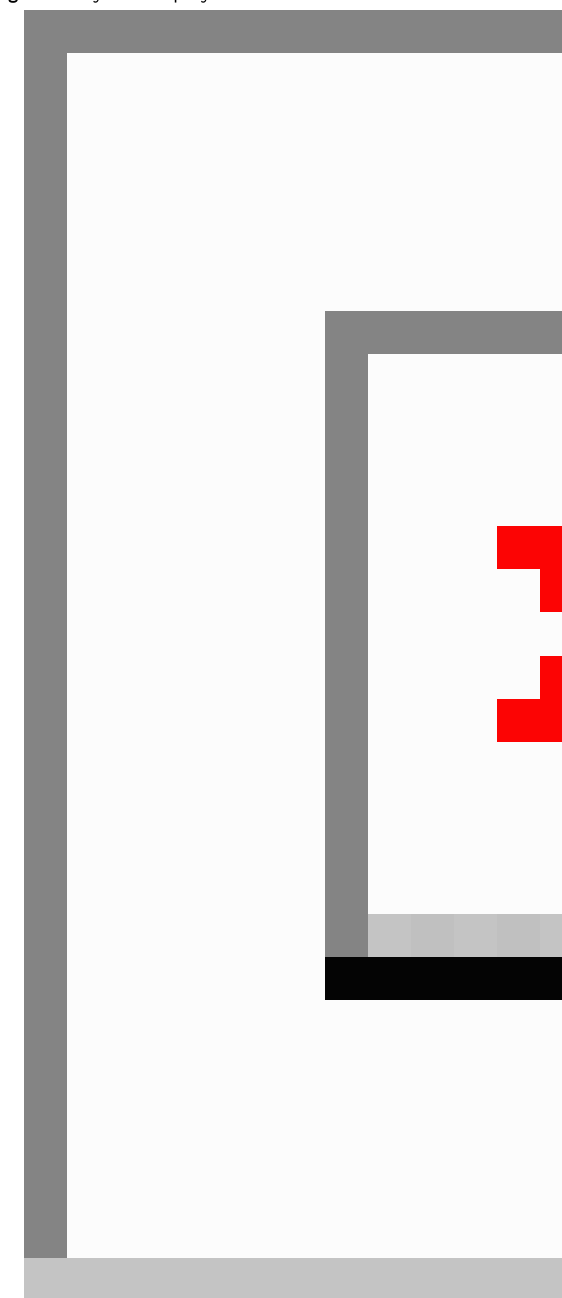
Figure 3. System